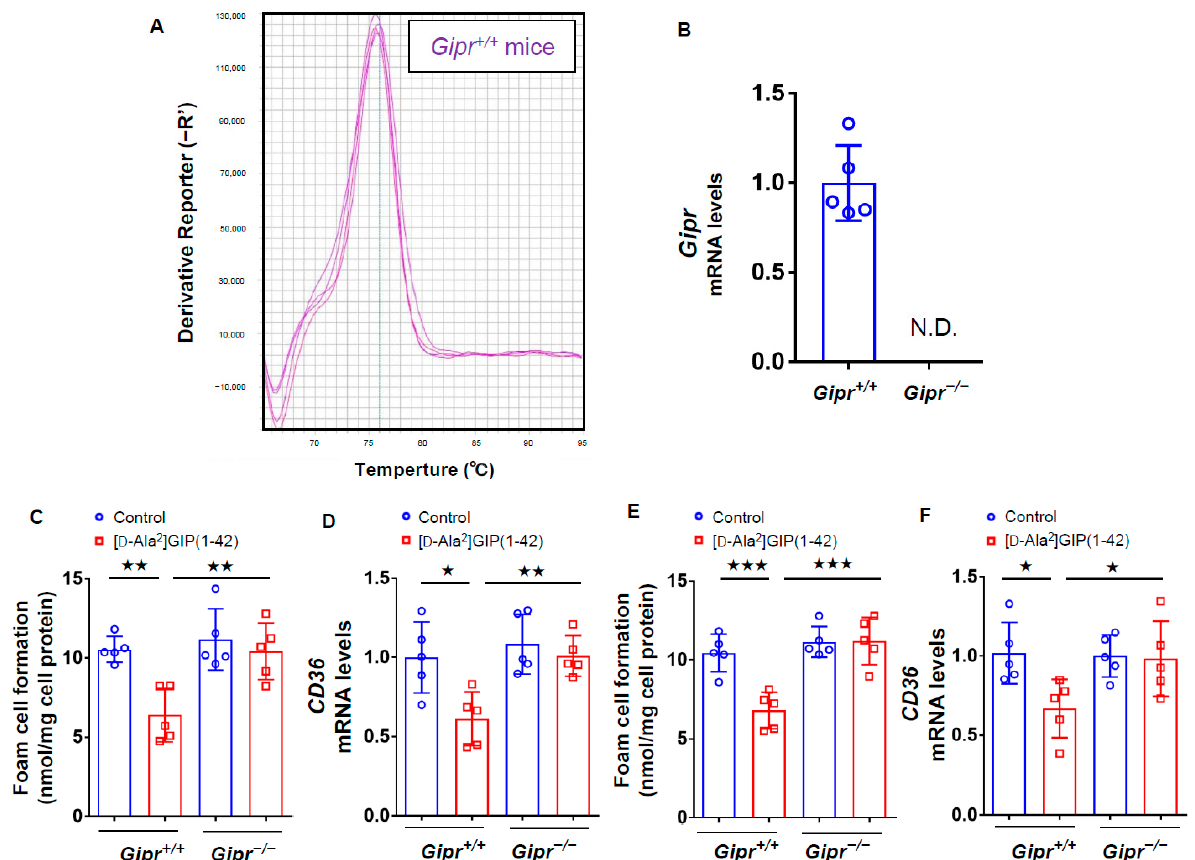
Figure 1. Effects of [D-Ala 2 ]GIP(1–42) on foam cell formation and CD36 gene expression in Gipr − / − mice and Gipr +/+ mice. Peritoneal macrophages were isolated from Gipr − / − mice and Gipr +/+ mice infused subcutaneously with or without [D- Ala 2 ]GIP(1–42) at 25 nmol/kg/day for 4 weeks. The cells were incubated with 10 µ g/mL ox-LDL containing at 0.1 mmol/L [ 3 H]oleate in RPMI 1640 medium supplemented with 10% fetal bovine serum (FCS) containing 100 U/mL penicillin and 100 µ g/mL streptomycin at 37 ◦ C in 5% CO 2 for 18 h. ( A ) Melt curve of gene expression of Gipr in peritoneal macrophages extracted from Gipr +/+ mice. ( B ) Gene expression levels of Gipr in peritoneal macrophages from Gipr − / − mice and Gipr +/+ mice. ( C , D ) Foam cell formation evaluated by the radioactivity of cholesterol [ 3 H]oleate ( C ) and CD36 gene expression levels ( D ) in macrophages isolated from Gipr − / − and Gipr +/+ mice infused subcutaneously with or without [D-Ala 2 ]GIP(1–42). ( E , F ) Macrophages were first extracted from Gipr − / − and Gipr +/+ mice, and then exposed to [D-Ala 2 ]GIP(1–42) at 1 nmol/L. Foam cell formation ( E ) and CD36 gene expression ( F ) were evaluated. Total RNAs were transcribed and amplified by real-time PCR. Values were normalized by the intensity of glyceraldehyde 3-phosphate dehydrogenase (GAPDH) mRNA-derived signals and then compared to the control intensities. Number = 5 for each group. Data are presented as mean ± standard deviation. The significant value was shown as ★★★ p < 0.005, ★★ p < 0.01 and ★ p < 0.05.